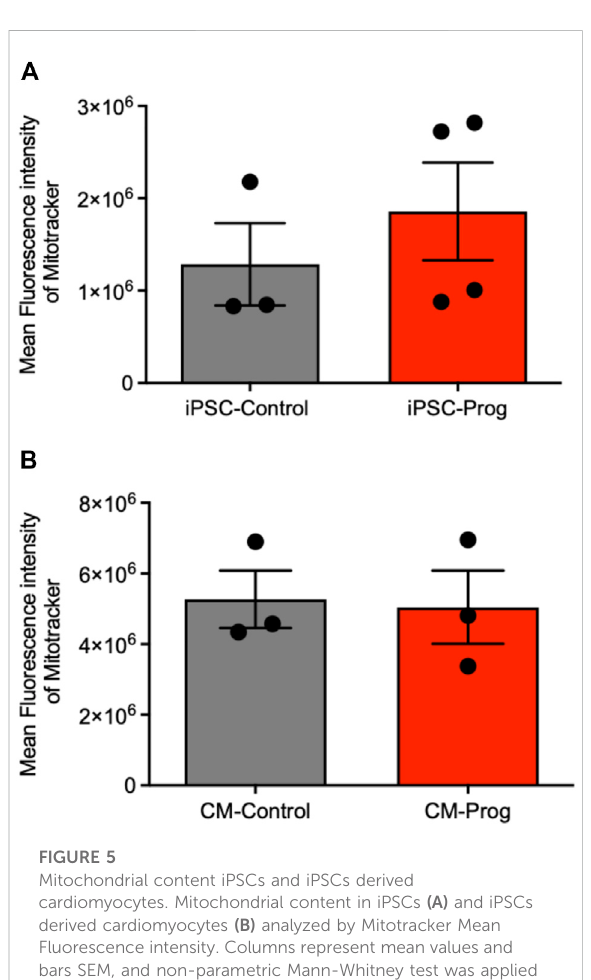
FIGURE 5 Mitochondrial content iPSCs and iPSCs derived cardiomyocytes. Mitochondrial content in iPSCs (A) and iPSCs derived cardiomyocytes (B) analyzed by Mitotracker Mean Fluorescence intensity. Columns represent mean values and bars SEM, and non-parametric Mann-Whitney test was applied (iPSC-Control n =3;iPSC-Prog n =4;CM-Control n =3;CM-Prog n = 3). FIGURE 6